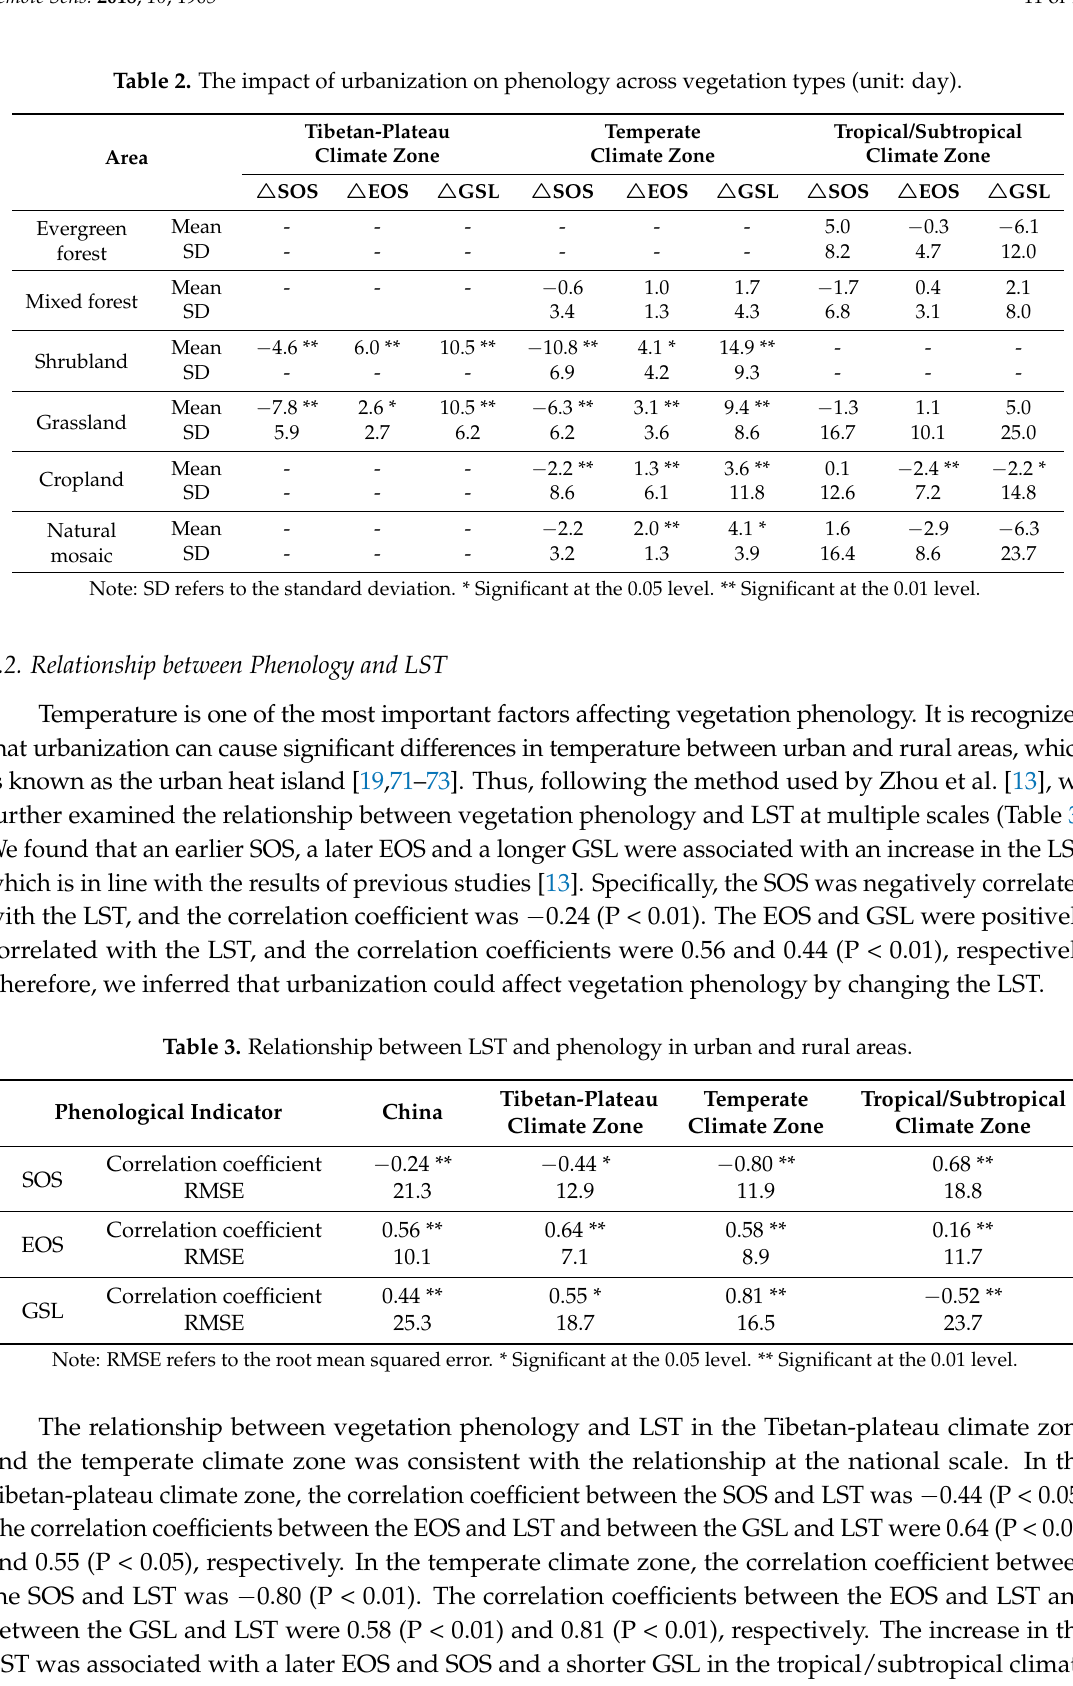
Table 2. The impact of urbanization on phenology across vegetation types (unit: day). Area Evergreen forest Mixed forest